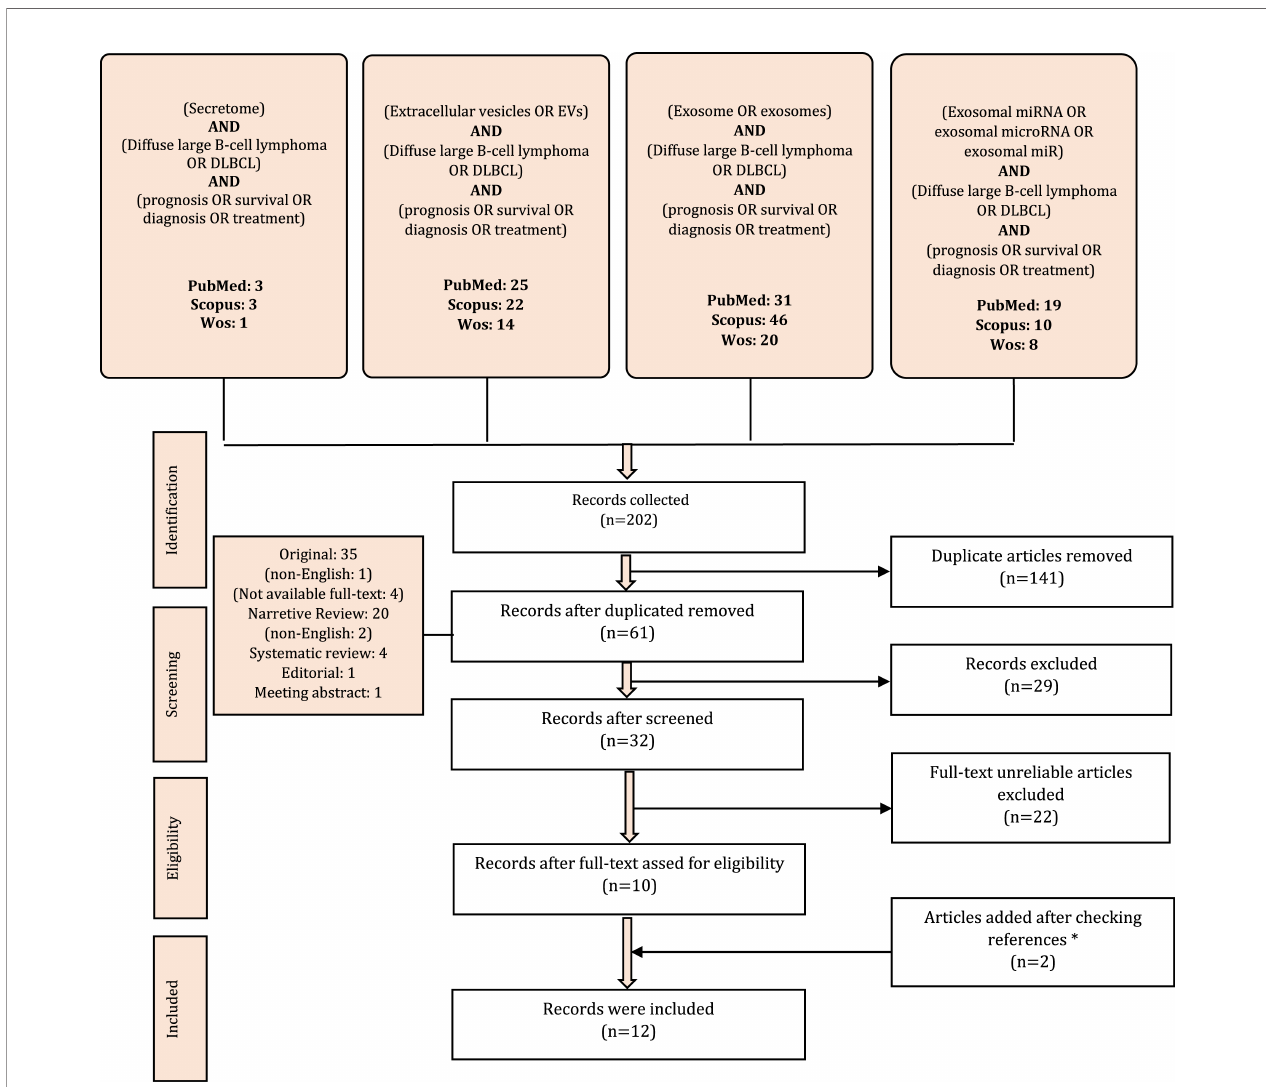
FIGURE 1 | Flowchart of study selection. *We also found two meeting abstracts but did not add them because of the similarity of data with the existing